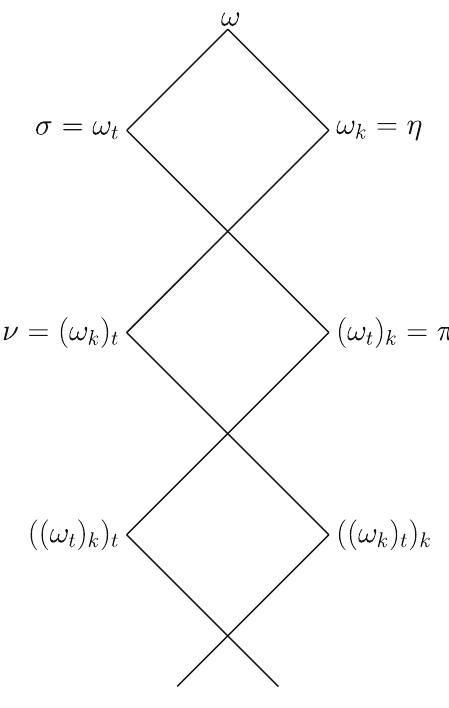
Figure 1: A min network of ( 2, 1 )-